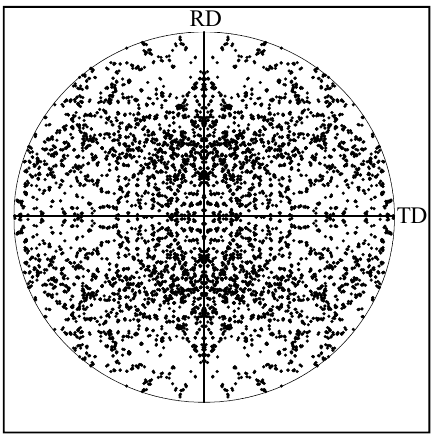
Figure 1. Initial crystallographic texture: {111} pole figure.